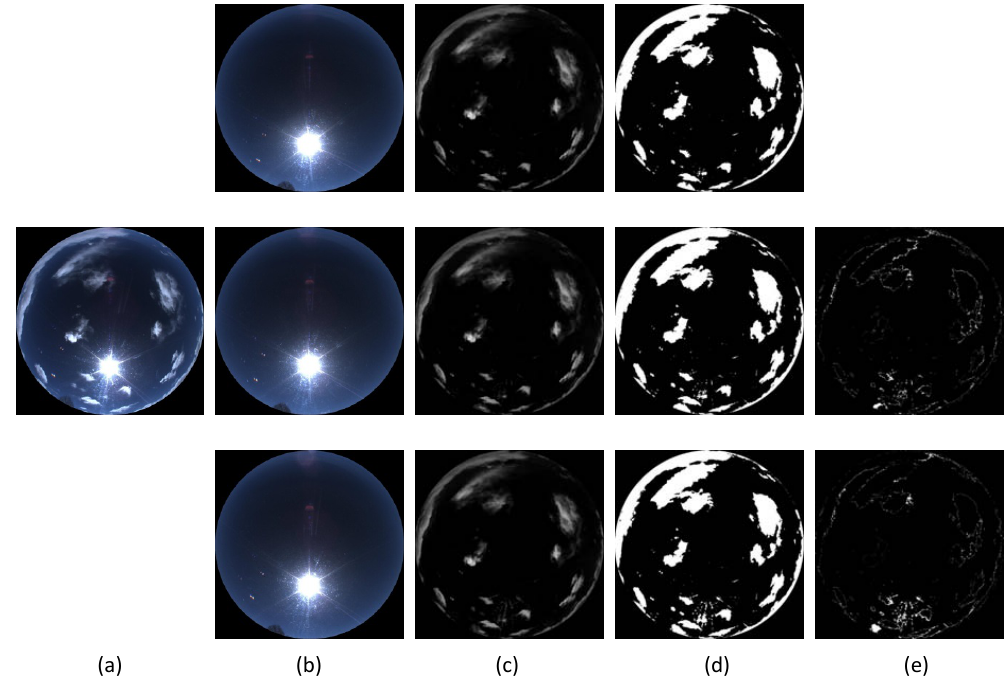
Figure 7. Sensitivity test as Fig. 6 but for medium solar elevation angle. Panel (a) is the TCI image after rotation, which was captured on 20 March 2013, (b) shows the CSB images, where the first row has the completely same solar elevation angle as (a) , the solar elevation angle of the second row has 2 ◦ deviation with (a) , and the solar elevation angle of the third row has 5 ◦ deviation with (a) , (c) shows the difference images, (d) shows the corresponding cloud detection results, (e) represents the differencing results between the 2 and 5 ◦ offset with the baseline result in row 1.